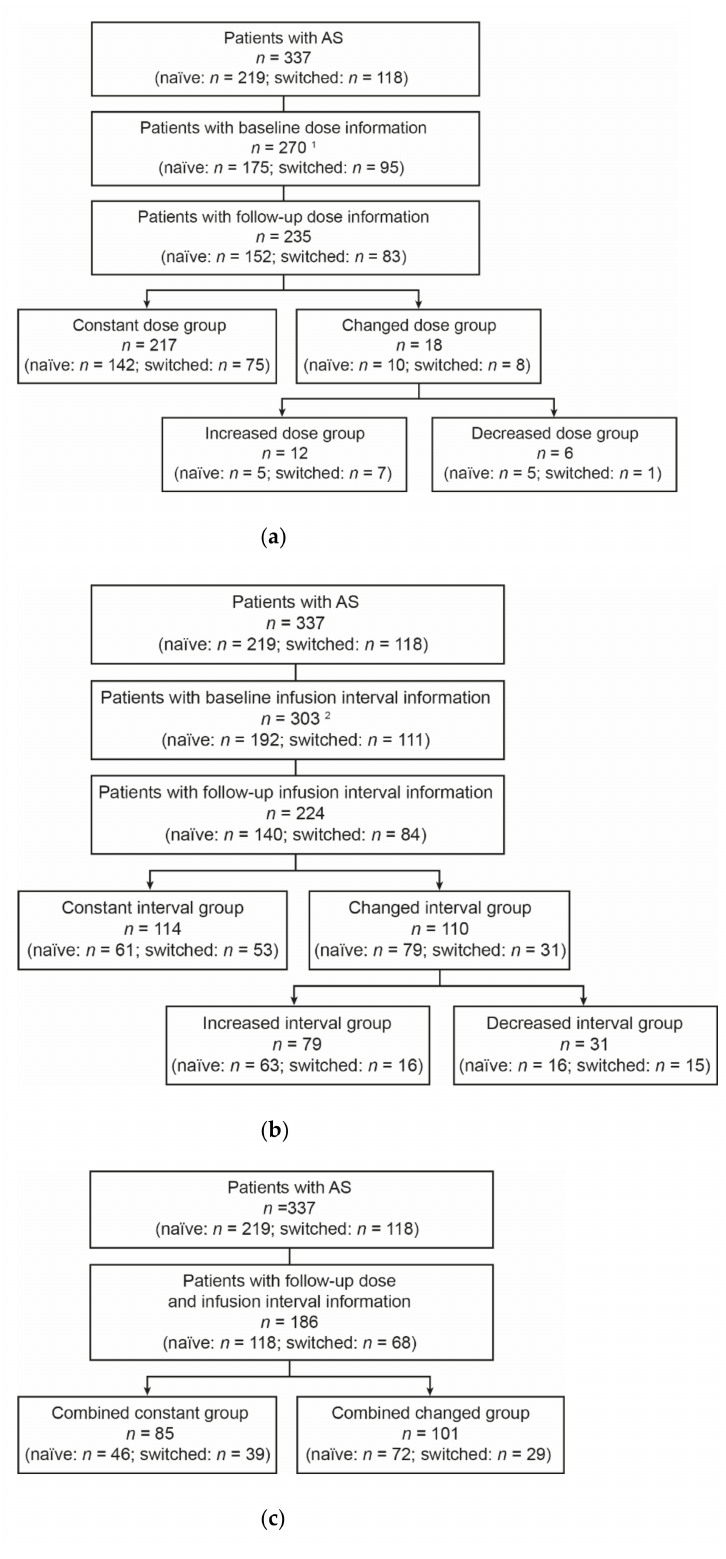
Figure 1. Analysis groups: ( a ) dose analysis groups, ( b ) interval analysis groups, and ( c ) combined dose/interval analysis groups. 1 Baseline dose was missing for 67 patients due to missing weight information ( n = 57) or missing dose after the induction period in naïve patients ( n = 10). 2 Baseline infusion interval was missing for 34 patients as there was no fourth infusion for naïve patients ( n = 27) or no second infusion for switched patients ( n = 7). AS, ankylosing